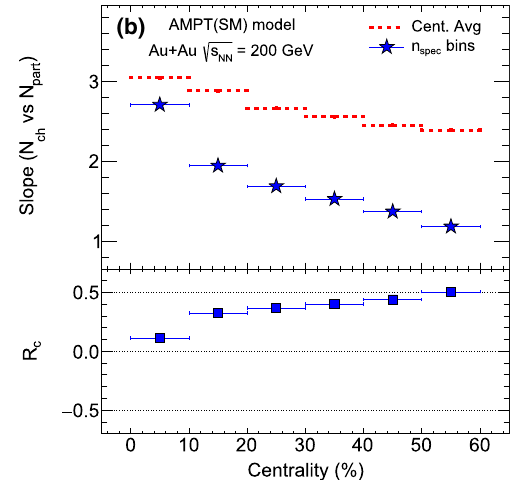
Fig. 4 Plots showing the method used to quantify the deviation of n spec binned values from the centrality trend in Au+Au collisions at √ s NN 200 GeV. (Left) d N ch / d η vs. N part showing the linear fits for cen- trality averaged values and L+R bins for each centrality in dotted lines. (Right) The extracted slope shown as a function of centrality, with the